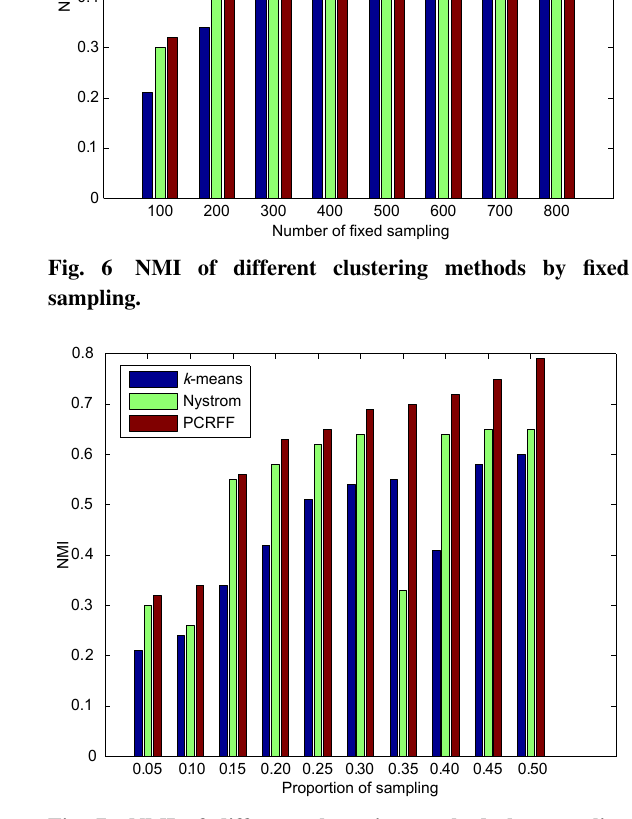
Fig. 4 Accuracy evaluation on different datasets.